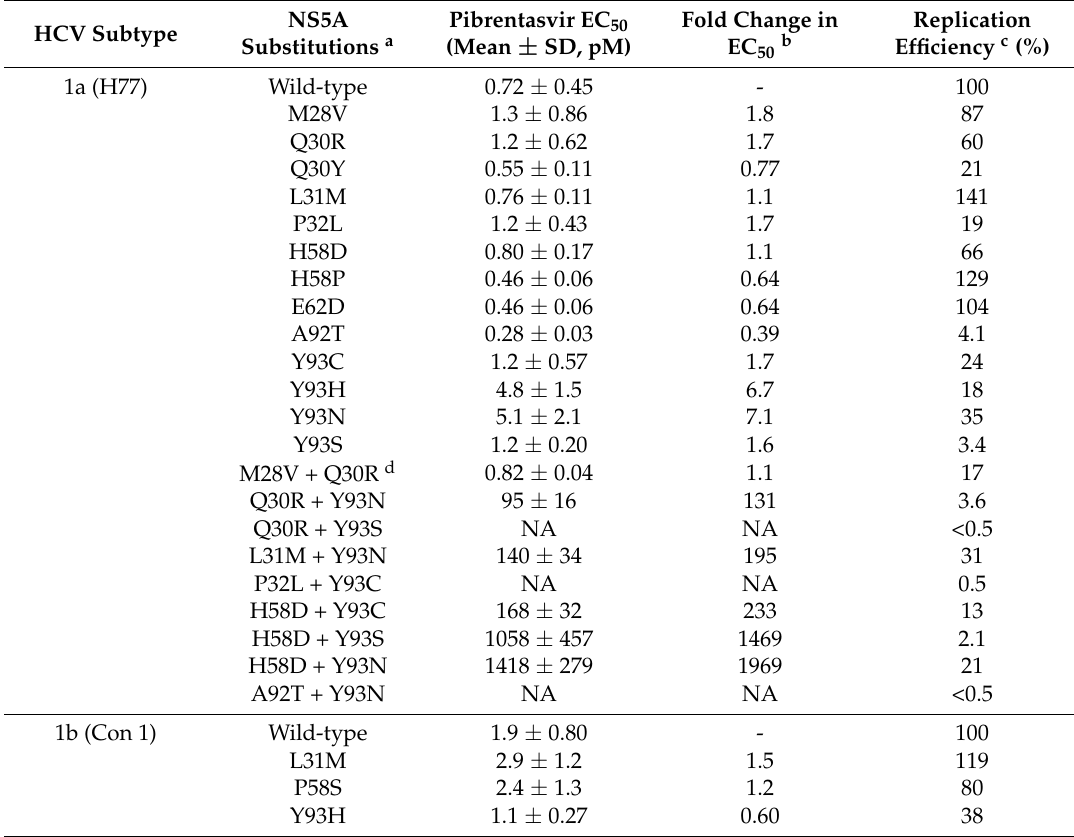
Table 5. Susceptibility of baseline or treatment-emergent NS5A substitutions to